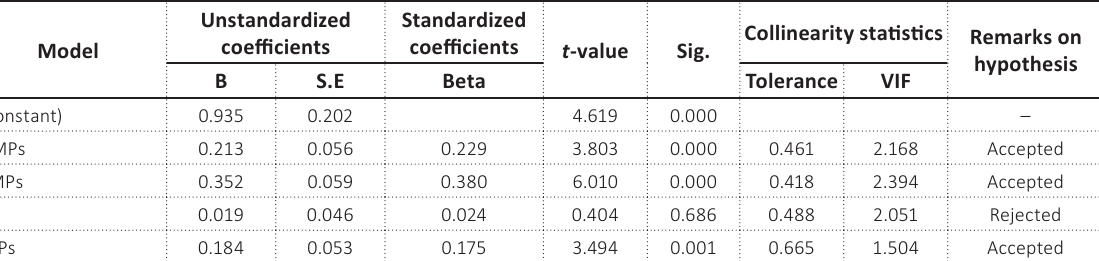
Table 5. IBPP regression coefficients of IBPP